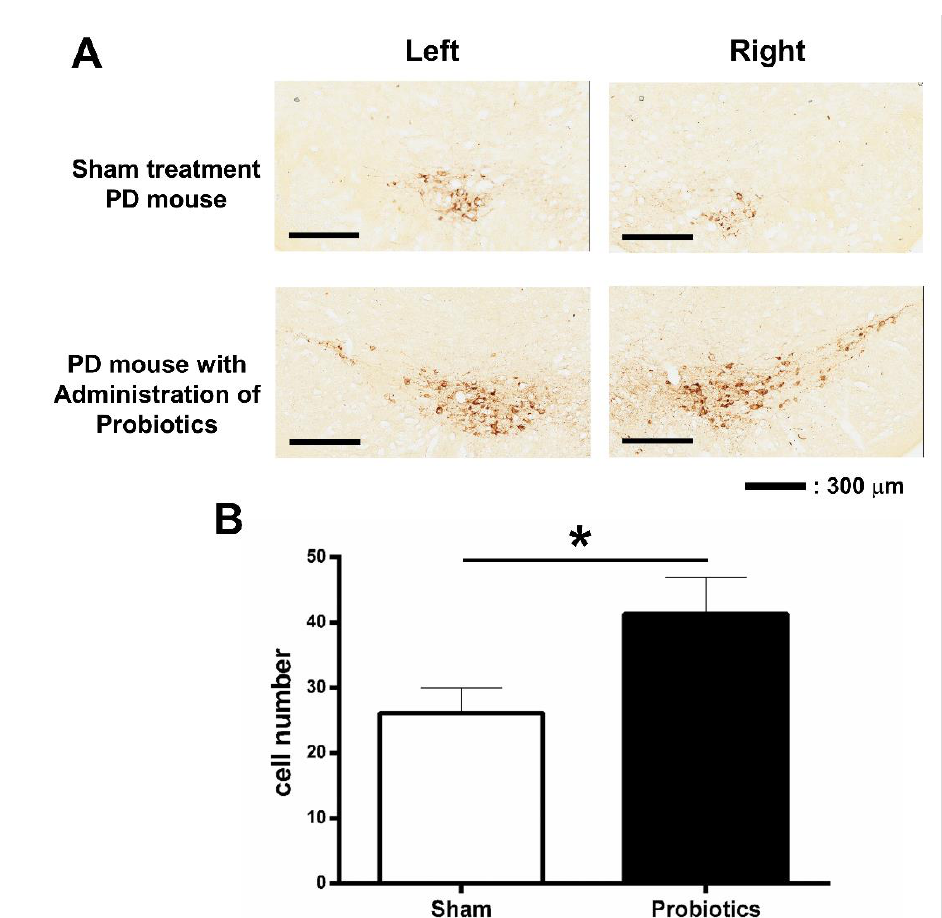
Figure 4. Representative tyrosine hydroxylase (TH) immunostaining in the substantia nigra pars compacta (SNpc) in PD mouse without probiotic treatment and in PD mouse with probiotic treatment ( A ). The average numbers of TH-positive neurons in the SNpc between sham treatment and probiotic-treated groups were compared ( B ). * p < 0.05 (unpaired t -test).